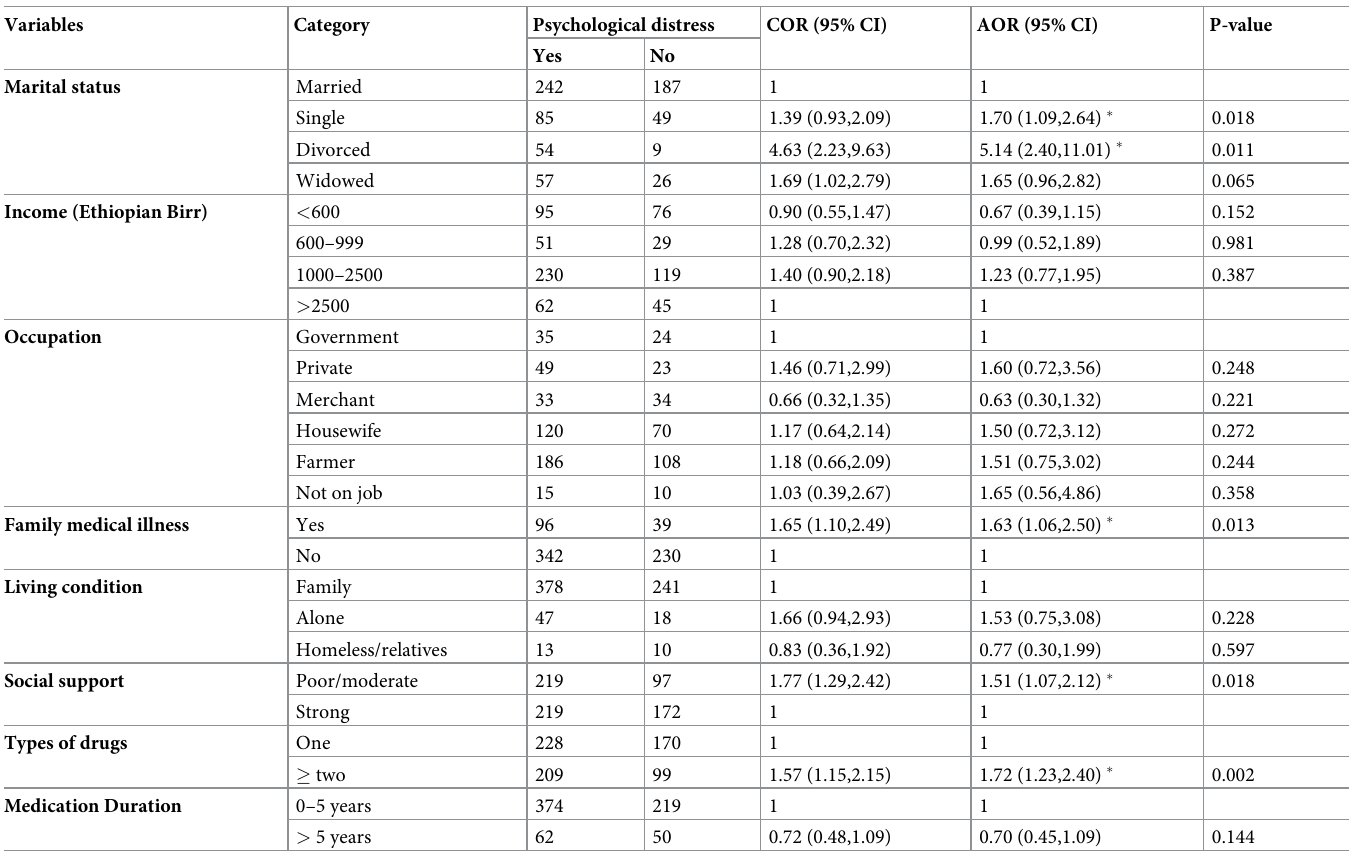
Table 3. Bivariable and multivariable analysis of psychological distress among people living with chronic medical illness in Mecha demographic research center, Ethiopia (n =